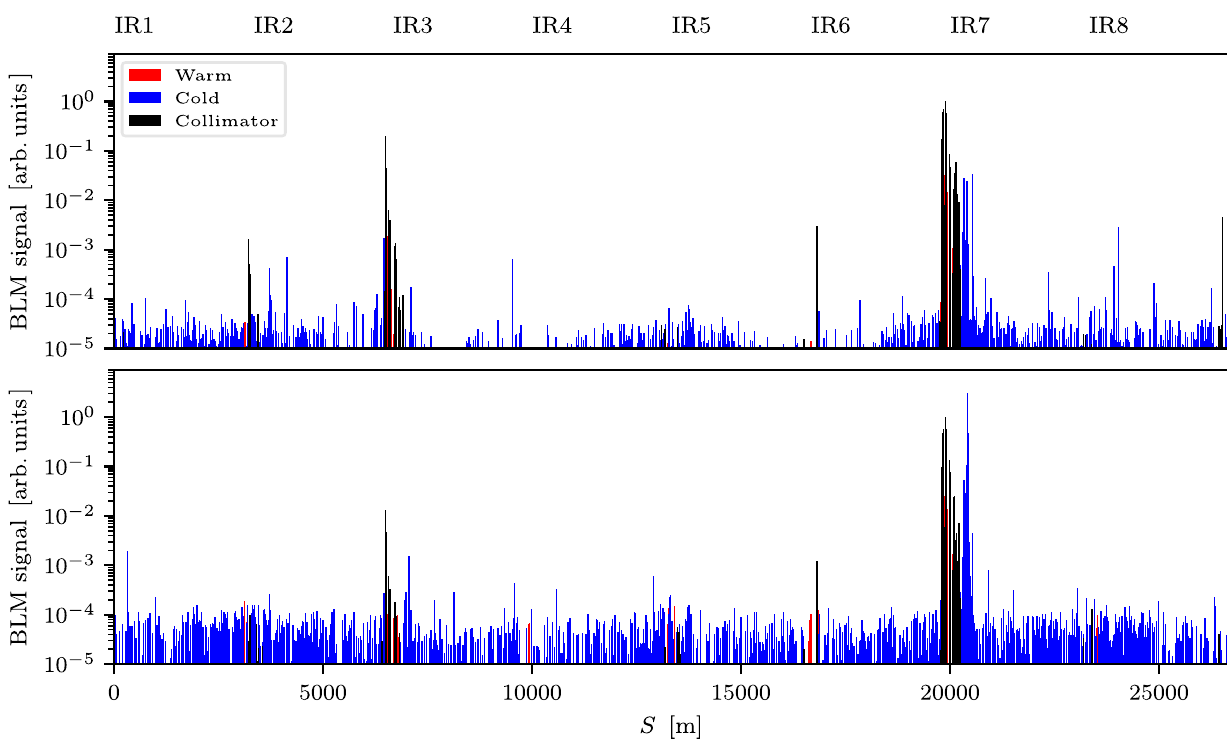
FIG. 2. LHC loss maps, indicating losses along the ring circumference. Black bars represent losses intercepted at the collimators. Blue regions represent the parts where superconducting magnets are located, and the red regions are related to the warm part of the ring. The top plot shows a loss map using a regular 208 Pb 82 þ ion beam at 6.37 Z TeV and the bottom plot shows a loss map with PSI ( 208 Pb 81 þ ) taken at 6.5 Q TeV, where Z is the ion atomic number, Q is the ion charge defined as Q ¼ Z − 1 .